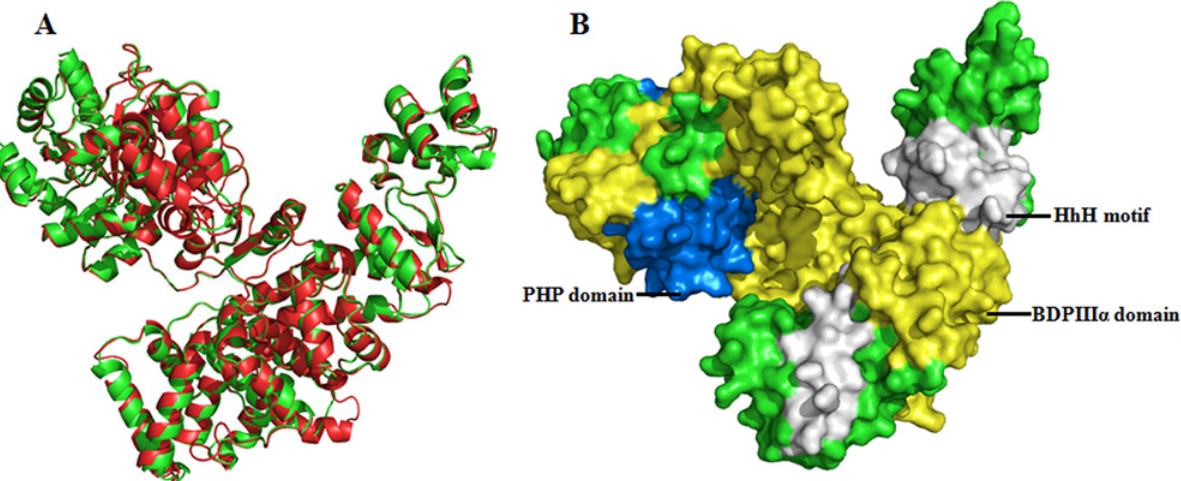
Fig 1. Superimposed Comparative Ribbon Model Structure and Conserved Domains of Mtb DnaE2. (A) Superimposed comparative model of Mtb DnaE2 (green) on the 2HNH_A (red) template with RMSD value (1.4 Å ). This model was generated by Modeller9v10. The model ’ s ribbon structure was visualized by PyMoL Viewer (B) Connolly surface form of Mtb DnaE2 model shows three out of the four conserved domains (identified by domain search) — PHP domain at N terminal, BDPIII α domain, and HhH motif visualized by PyMOL viewer. The OB fold domain identified in the C-terminal region of Mtb DnaE2 can not be seen, due the absence of C-terminal region in the template